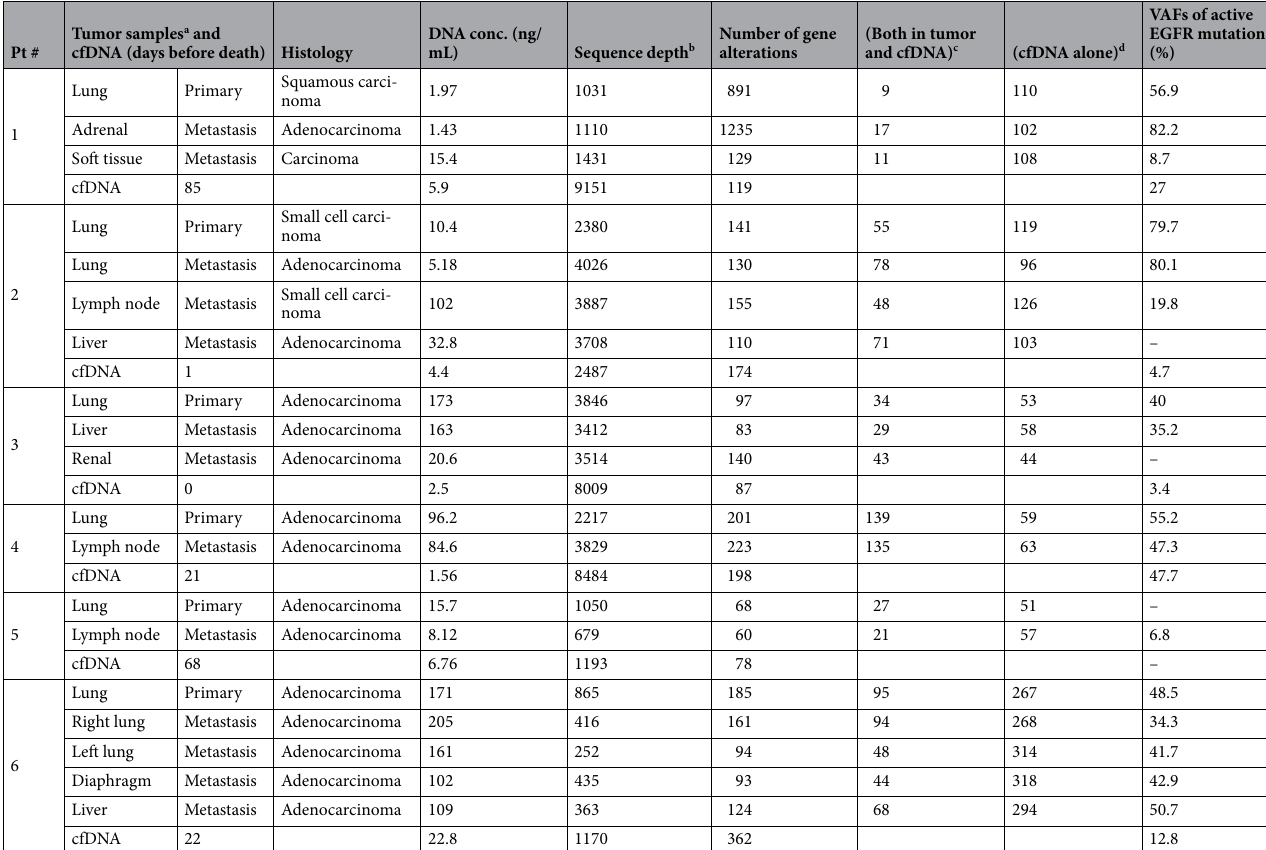
Table 2. DNA sample characteristics and the gene alterations detected by next-generation sequencing. conc. concentration, VAF variant allele frequency. a Tumor samples were collected from autopsy. b The sequence depth indicates a median number of that in target lesions. c Number of gene alterations both in tumor and cfDNA are listed. It is the number gene of alterations detected in cfDNA among alterations in tumor. d Number of gene alterations in cfDNA alone are listed. It is the number of alterations detected in cfDNA, not in